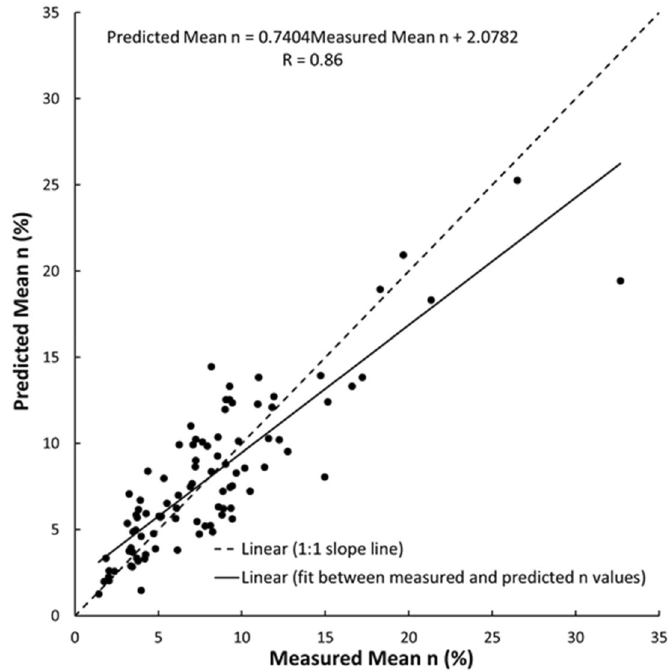
Figure 25. Cross-correlation of the measured and predicted values estimated from V p in terms of n values of